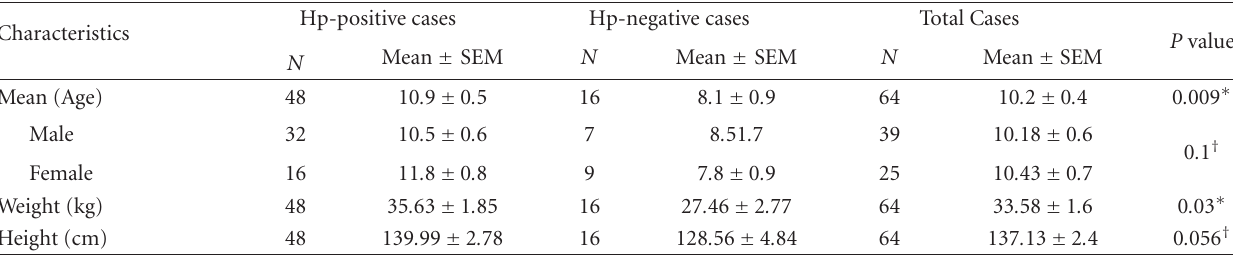
Table 2: Details of cases included in the study.